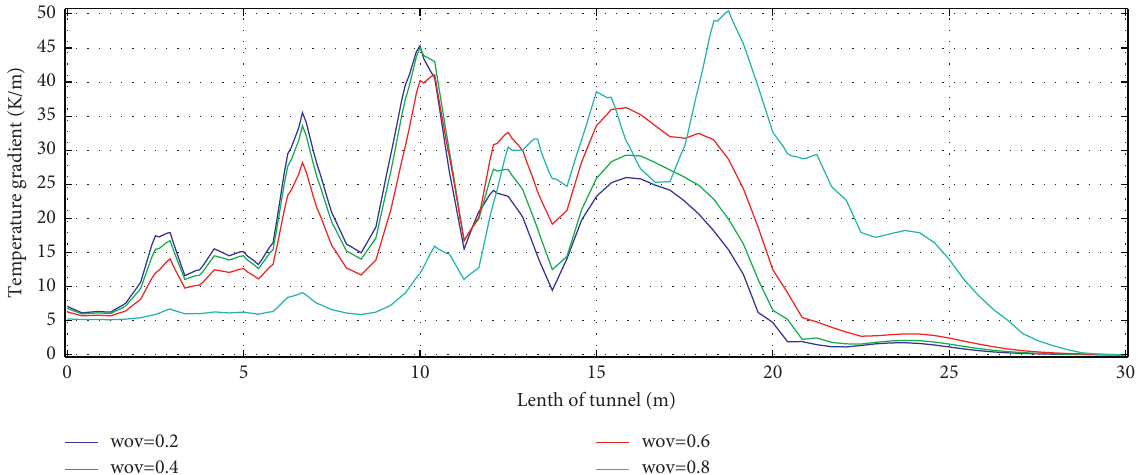
Figure 12: Gradient of air temperature distribution inside the tunnel under different